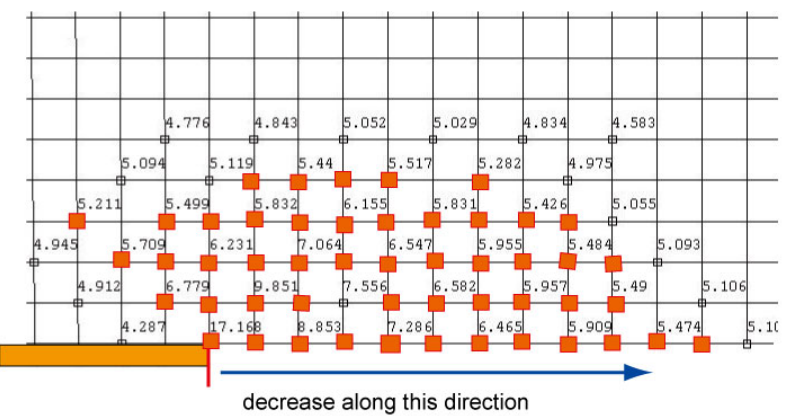
Figure 13. The specific value around the region at the end of the